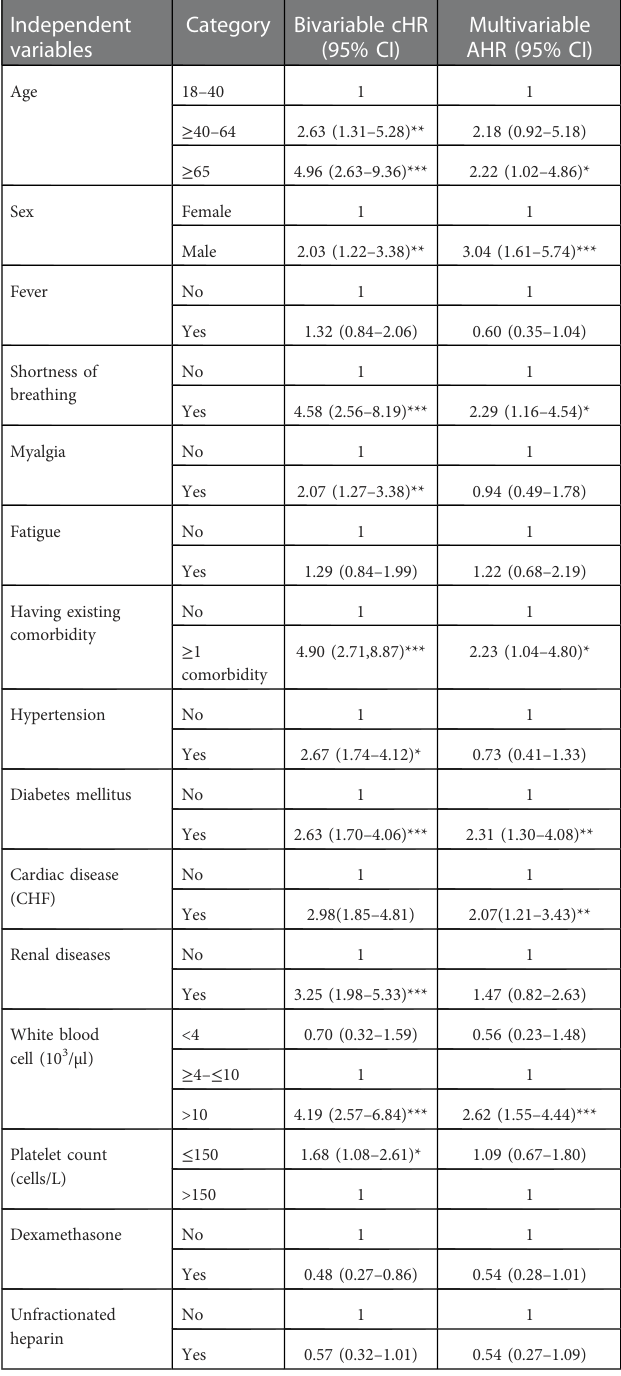
TABLE 3 Cox proportional hazard model analysis for predictors of time to death among adults with COVID-19 at Eka Kotebe General Hospital, COVID-19 Treatment Center, Addis Ababa, Ethiopia,